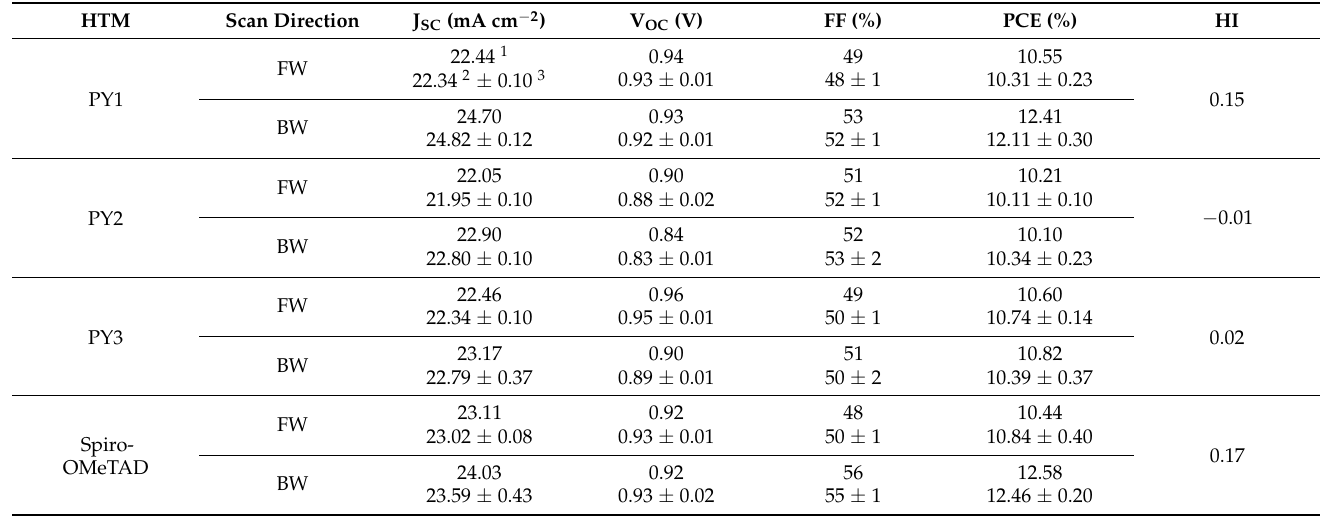
Figure 5. ( a ) Best J-V curves of the champion PSCs based on different doped HTMs measured under simulated AM1.5G illumination; active area = 0.20 cm 2 . ( b ) Corresponding IPCE spectra. ( c ) Stabilized photocurrent density obtained while holding the best PSCs at a bias voltage of 0 V and under continuous illumination. Table 2. Photovoltaic parameters of the PSCs based on different HTMs.